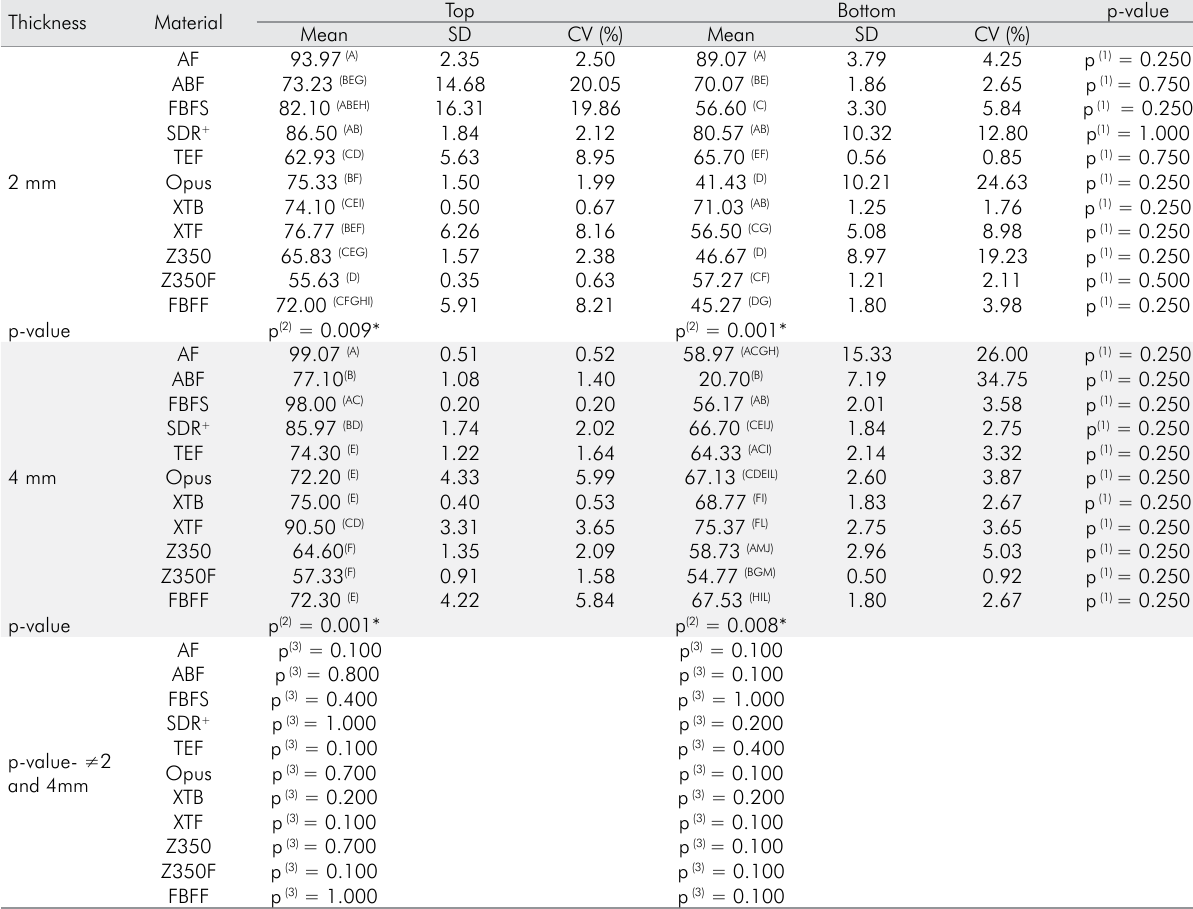
Table 5. Mean ± standard deviation of degree of conversion according to material and thickness, and the surface of the test specimen subjected to